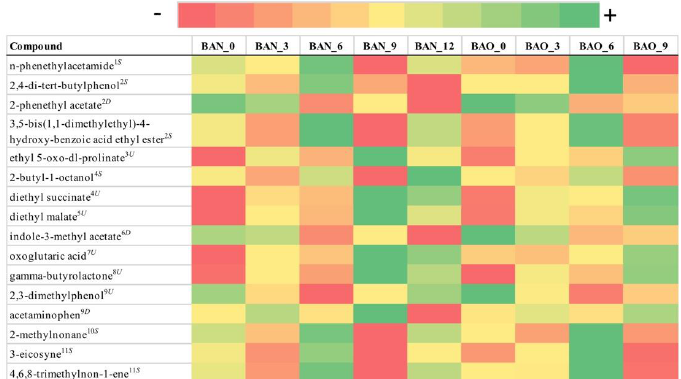
Figure 6. Color coded visualization of Table S5 included in the Supplementary Materials showing the metabolites detected by GC-MS with statistical and practical significance, for cellar FB. Numbers at the end of the sample acronyms represent the sampling month. The color gradient was individualized for each metabolite and the numeric values representing the area of the detected chromatographic peaks after applying variance stabilization are available in Supplementary Table S5. The metabolites can be grouped in the following chemical classes: (1) amines, (2) benzene and substituted derivatives, (3) carboxylic acids, (4) fatty acyls, (5) hydroxy acids, (6) indoles, (7) keto acids, (8) lactones, (9) phenols, (10) saturated hydrocarbons, (11) unsaturated hydrocarbons. Metabolites that exhibited increasing tendency are indicated as superscript (U) and those with decreasing tendency as superscript (D), whereas metabolites with relatively stable concentrations but with a peak on the 6th month are denoted as (S).